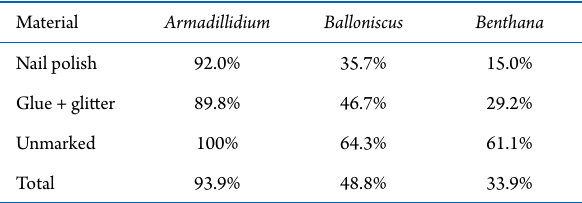
Table 1. Percentage of the remaining animals bearing all four marks in the end of 28 days of